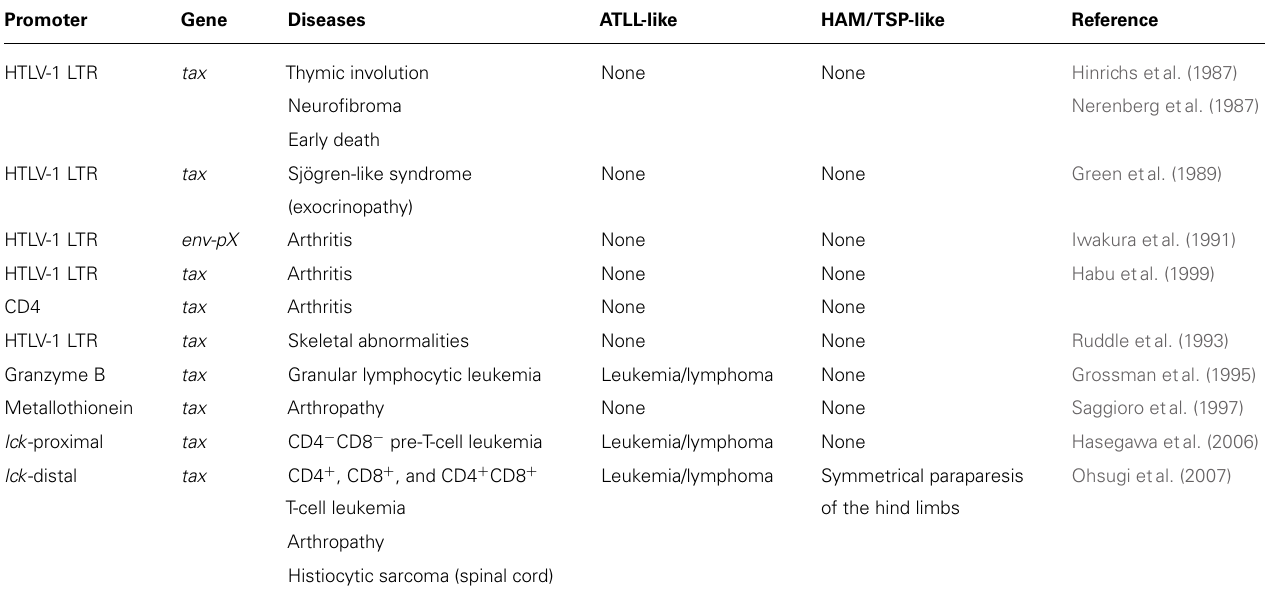
Table 1 | Representative tax transgenic mouse